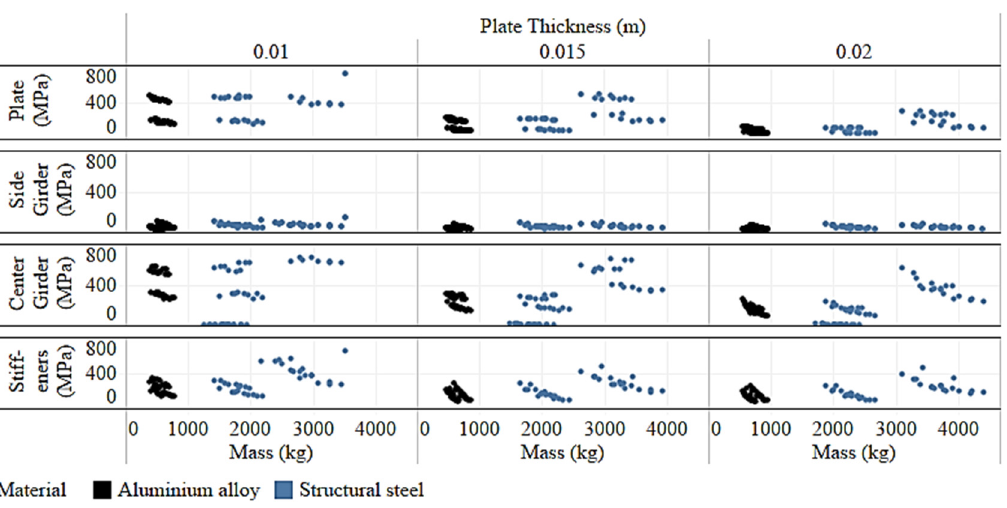
Figure 18. Contribution from different structural elements of a metal grillage towards strength.